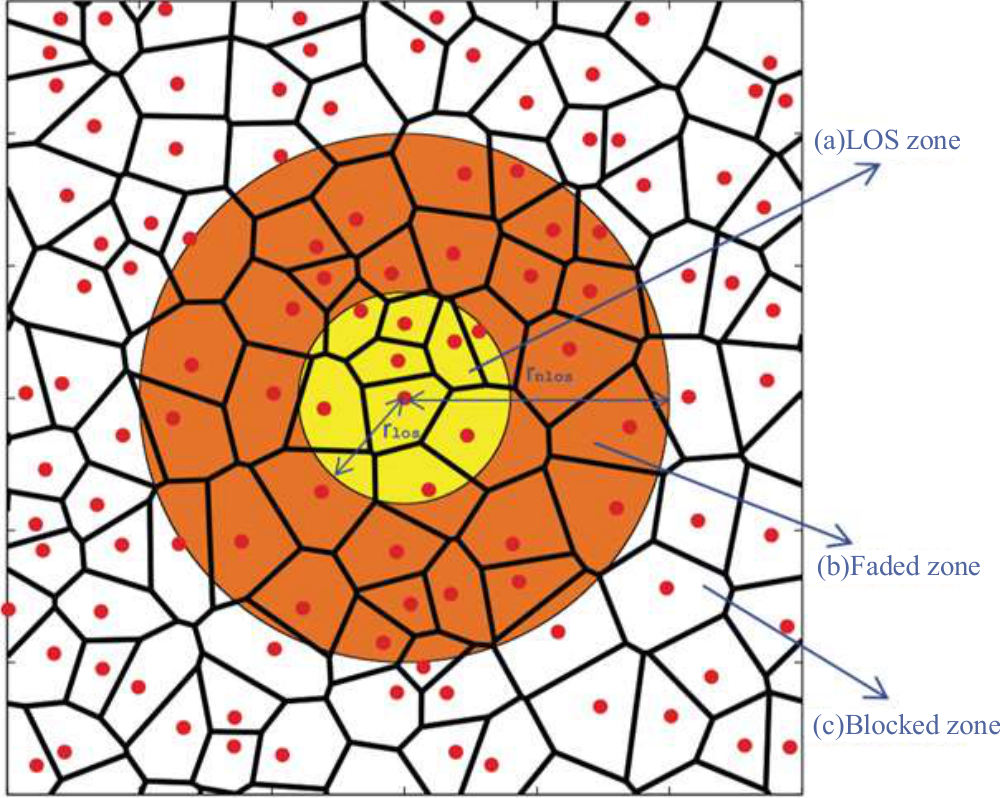
Figure 1. A typical wireless communication network. Red dots represent the BSs, while those thick- black lines symbolize the polygon cells. This network is made up of three specific areas: ( a ) LOS area is the inner circle; ( b ) Faded or NLOS area is those annular regions with orange color; ( c ) Blocked area is those regions which are outside the colored circle [4].